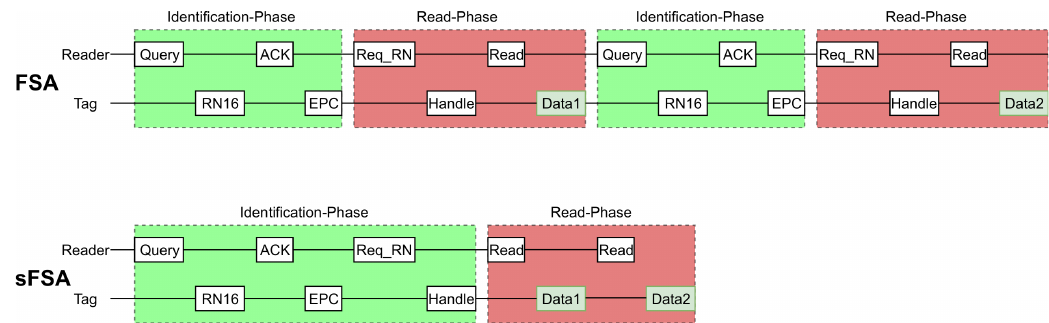
Figure 5. Comparison of the streaming procedure using the standard EPC C1G2 on top of the figure, and the proposed approach below for N = 1 and S = 2.